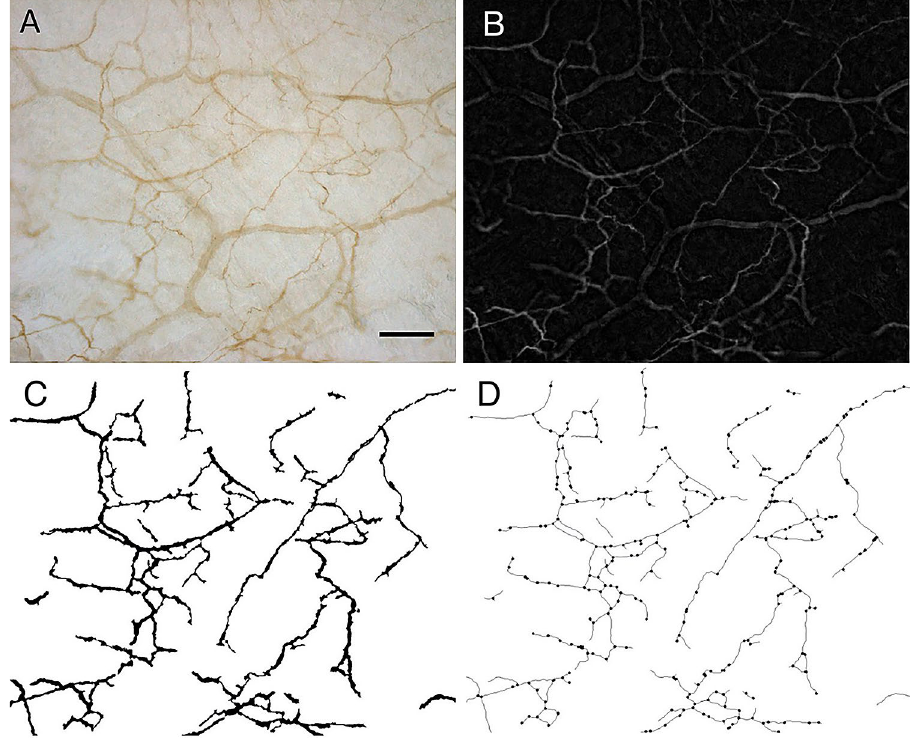
Figure 10. Images processing and morphometric analysis of the pattern of nerve fibers: ( A ) original picture of one S100 reaction; ( B ) top-hat filter applied in picture A to enhance the contrast; ( C ) binary image of nerve network; ( D ) final binary skeleton derived from picture C and identification of the branching points. Scale bar: 100